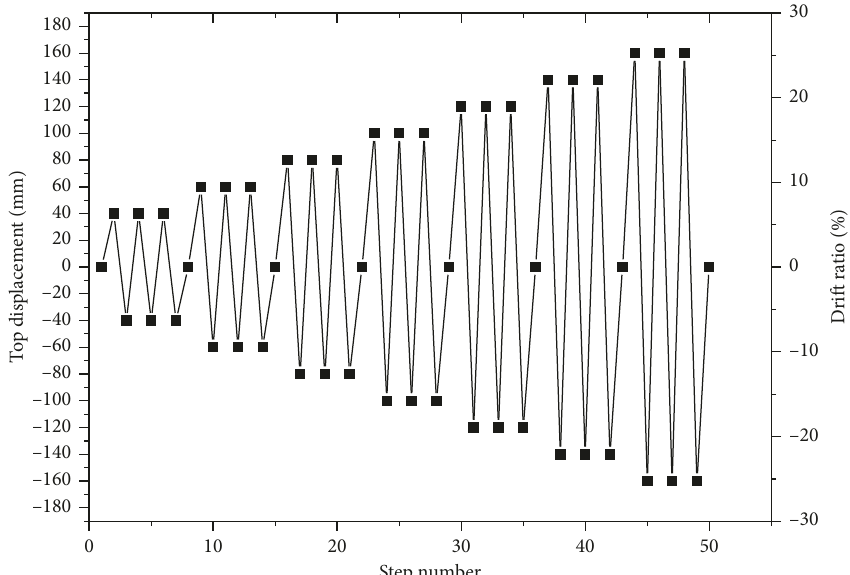
Figure 7: Loading strategy of the standard loading test.